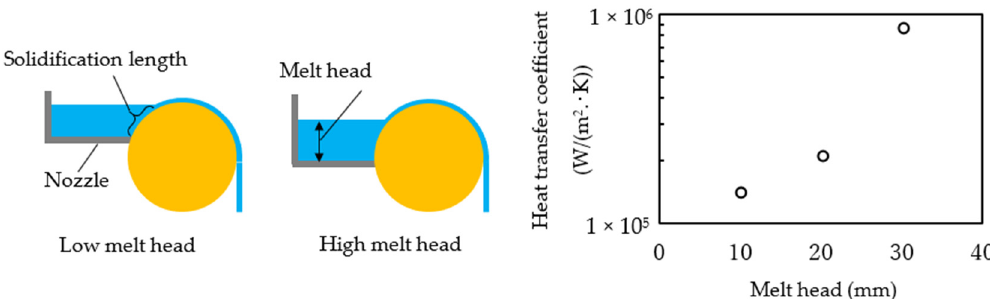
Figure 1. Effect of molten melt head on heat transfer coefficient between molten metal (or solidification layer) and the roll. The roll speed is 30 m/min. Al-12%Si was used.